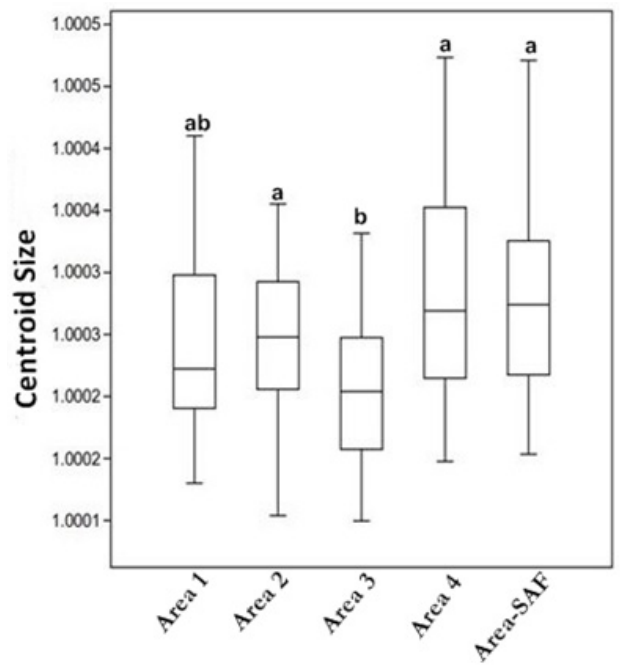
Fig 4 . Box Plot and Tukey’s Range Test for the centroid size of Euglossa ignita . The horizontal lines represent the medians; the rectangles represent the interquartile range (25-75%), while the vertical lines inform the intervals of variance. By Tukey’s range test, the same letters do not differ statistically from each